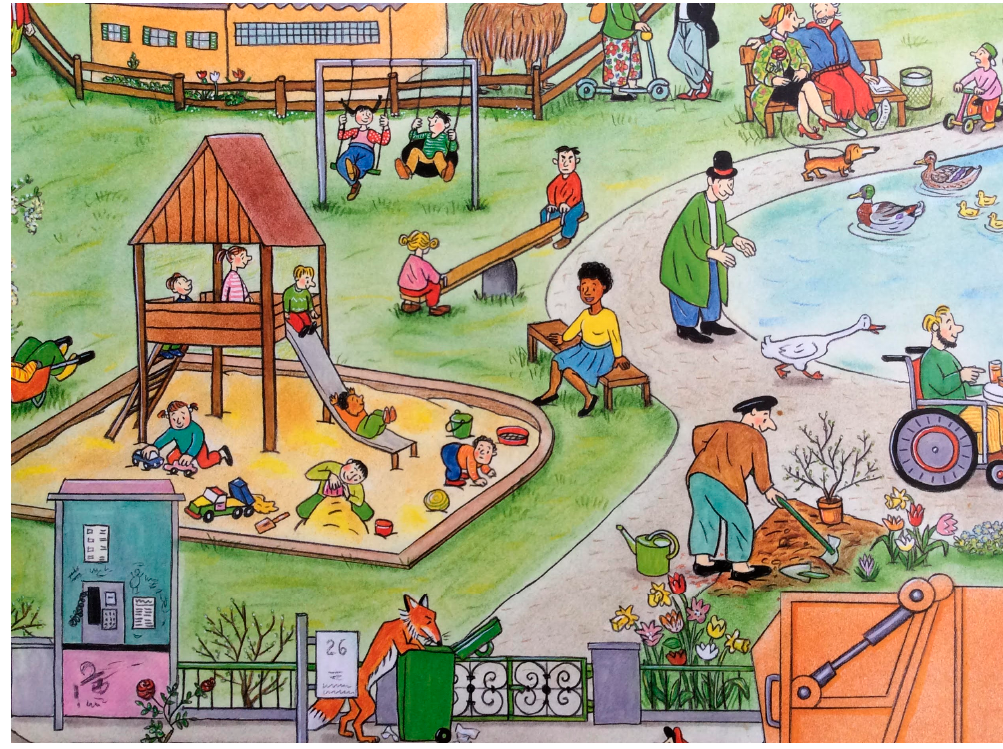
Figure 1. Detail from Spring-Wimmelbook